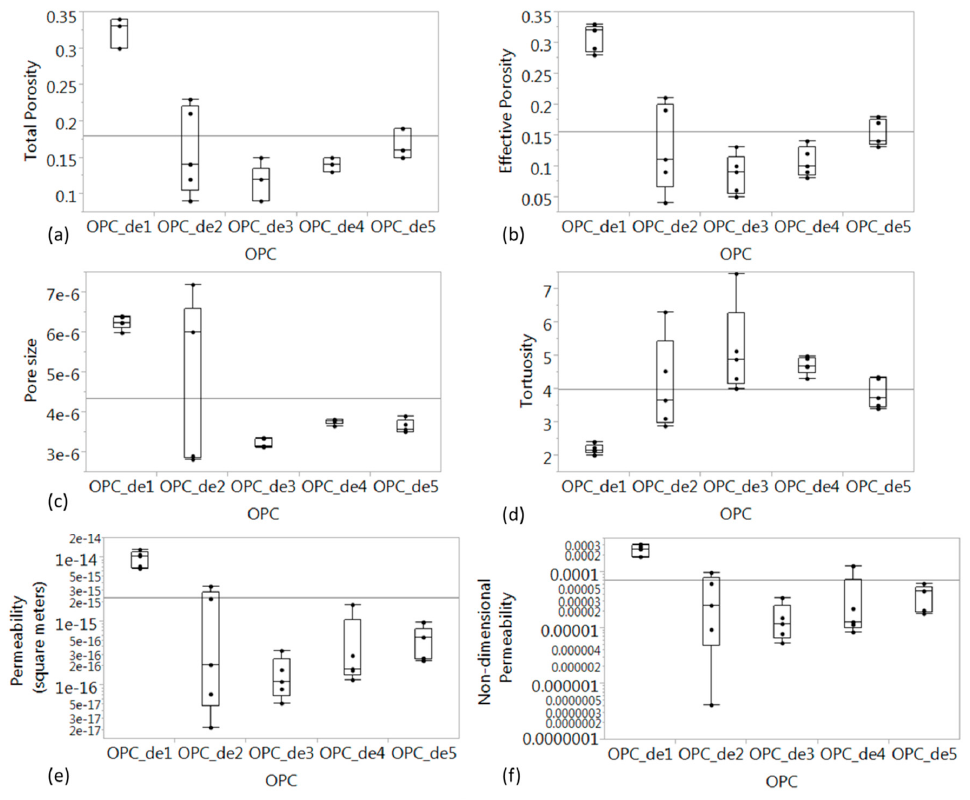
Figure 7. Summary of microstructure and transport properties in different regions: ( a ) Segmented total porosity; ( b ) effective porosity; ( c ) mean pore size (m); ( d ) tortuosity; ( e ) intrinsic permeability (m 2 ); ( f ) Non-dimensional permeability, i.e. , intrinsic permeability normalized by square of the mean pore size.